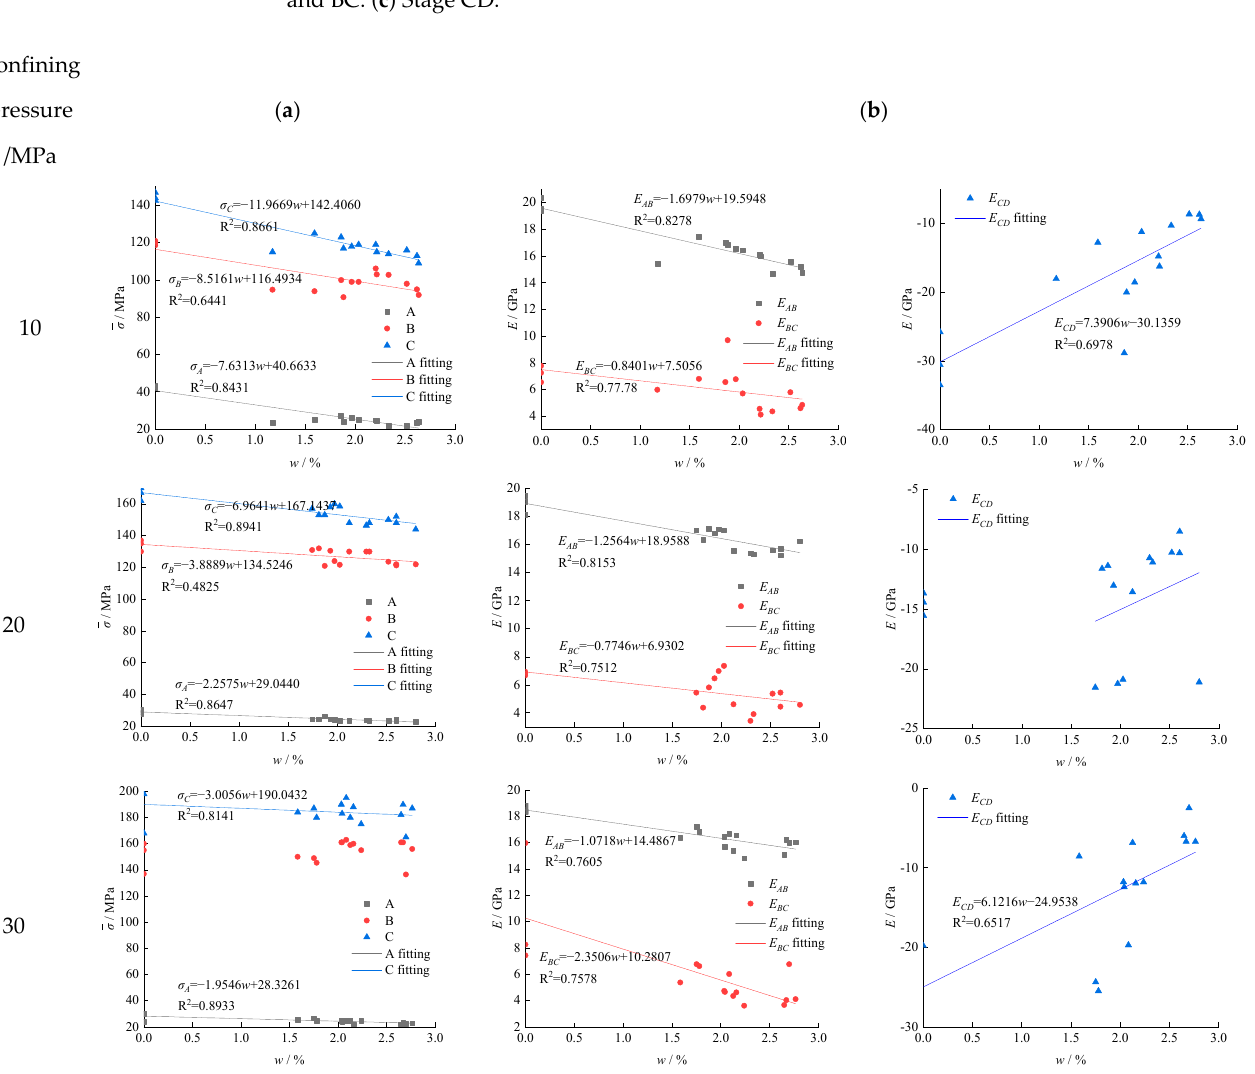
Figure 8. The mechanical turning points of the specimen under triaxial compression, and the strength variance rate corresponding to the water content. ( a ) Strength at the mechanical turning point. ( b ) Strength variance rate.